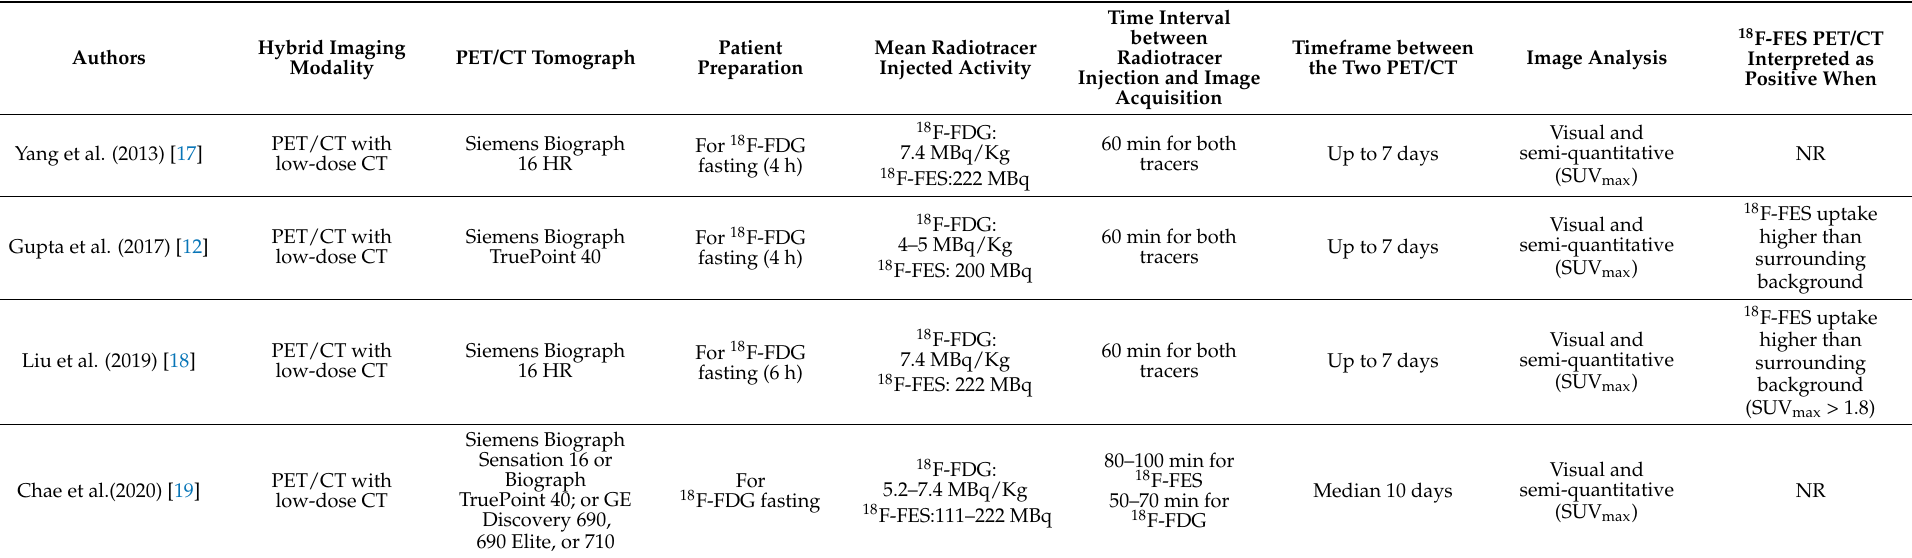
Table 2. Technical aspects of PET imaging in the included